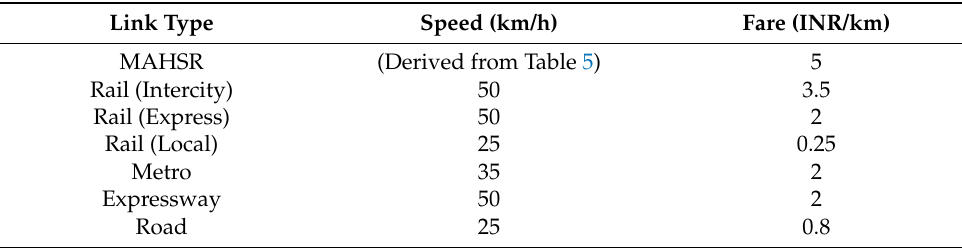
Table 4. General conditions of transportation mode links (source: authors).